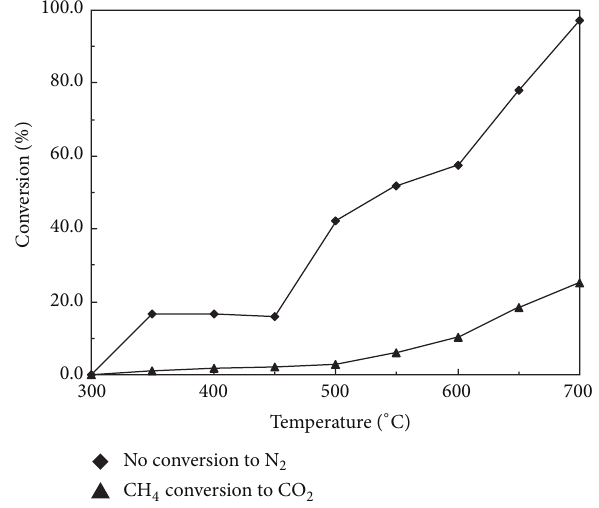
Figure 6: NO conversion to N 2 and CH 4 conversion to CO 2 without O 2 over In/HZSM-5/In 2 O 3 . Feed gas: 0.25% NO, 0.2% CH 4 , and the balance of He; GHSV = 3600 h −1 .